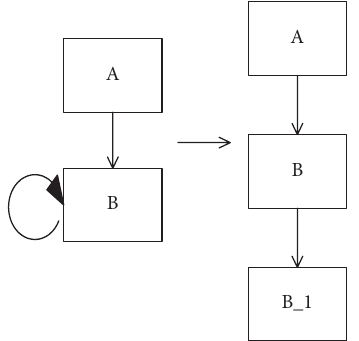
Figure 3: Conflict resolution in unary